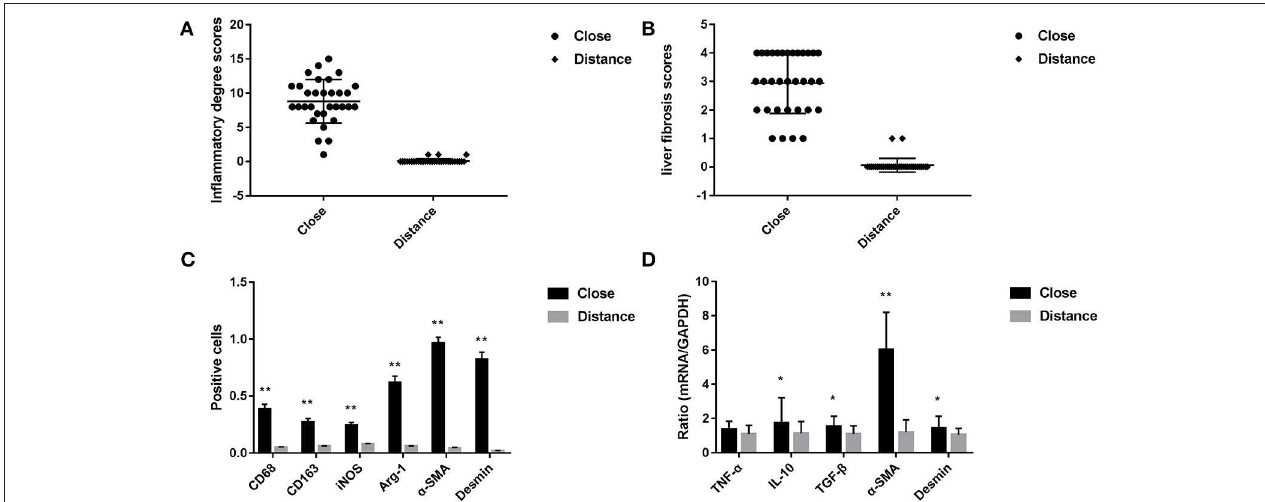
FIGURE 2 | (A) Pathological score of liver tissue inflammatory changes in patients with hepatic AE (after H&E staining, score criteria refers to the Table 2 ). (B) Liver fibrosis score in patients with hepatic AE (after Masson staining, refers to METAVIR scoring standard). (C) Immunohistochemical positive cells area of liver tissue in patients with hepatic AE (magnification, × 400). KCs surface markers CD68 and CD163, pro-inflammatory cytokine iNOS, anti-inflammatory cytokine Arg-1 were differentially expressed in immunohistochemical staining between the two groups. The difference in the HSCs activation markers α -SMA and Desmin between the two groups ( ** P < 0.01, compared with Distance group). (D) Gene expression levels of KCs and HSCs activation ( * P < 0.05, ** P < 0.01, compared with Distance group).